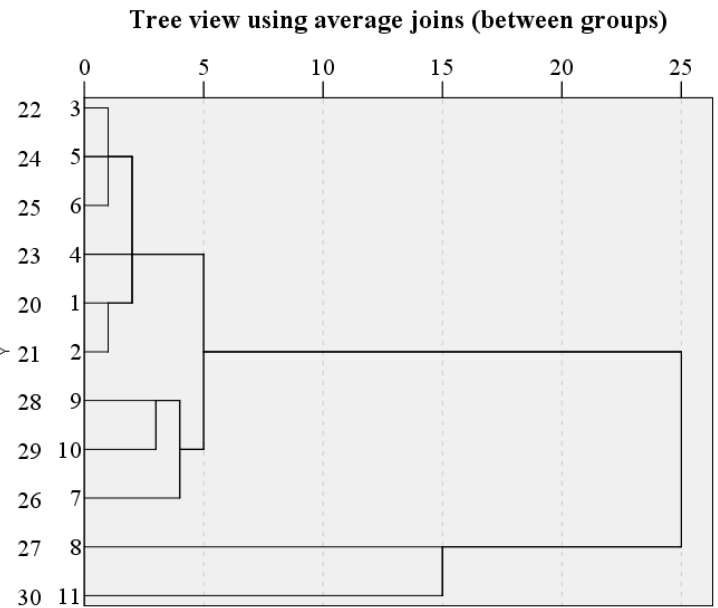
Figure 11. Cluster analysis of Ordovician limestone water system.